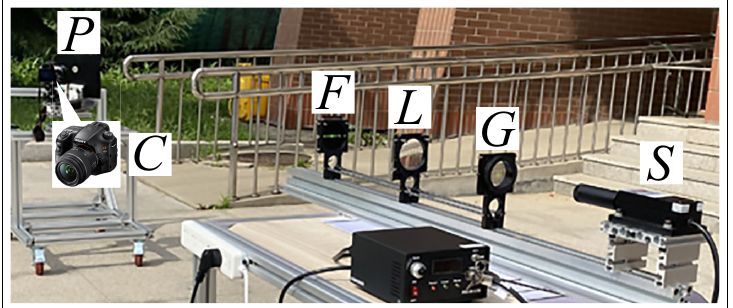
Figure 1. Photo of in-situ measurement under the sunlight via using the projection of sinusoidal fringe patterns generated by the designed optical system. C —Camera; F —spatial-frequency filter; G —grating; L —lens; P —observation plane; S —CW laser